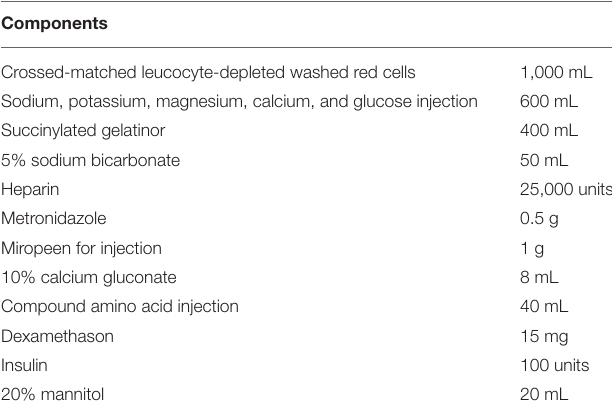
TABLE 1 | Components of the perfusate solution.